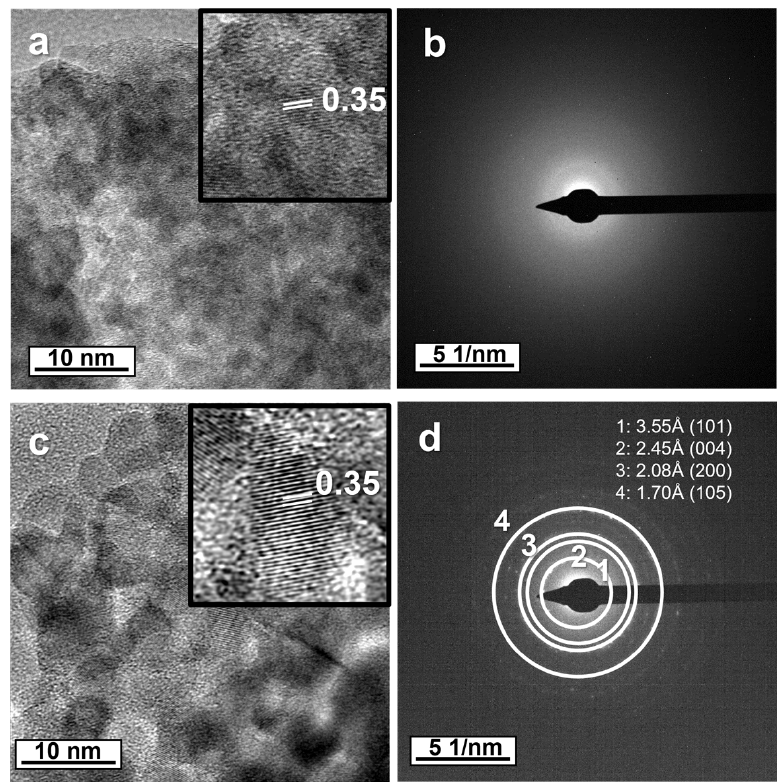
Figure 5. Bright-field images ( a , c ) and electron diffraction patterns ( b , d ) of FA-S2-3-300 sample ( a , b ) and FA-S2-3-500 sample ( c , d ).